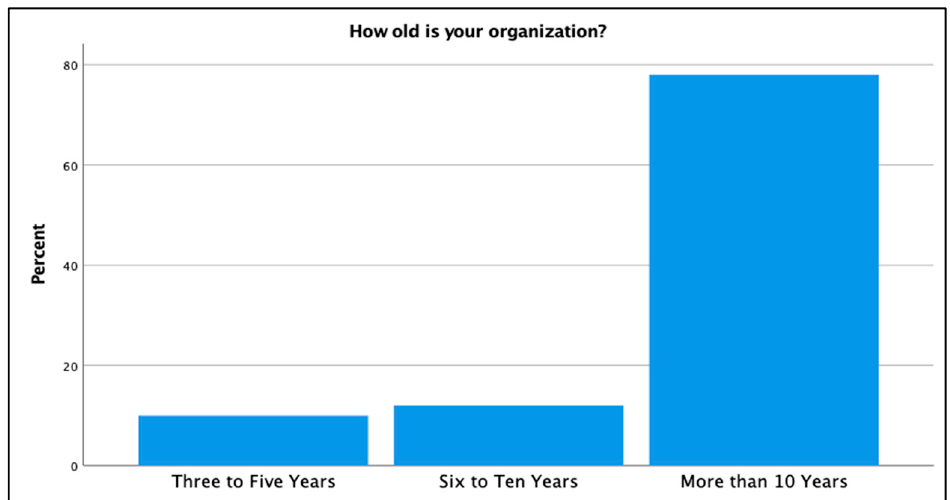
Figure 4 . Company Age. Figure 4. Company Age.